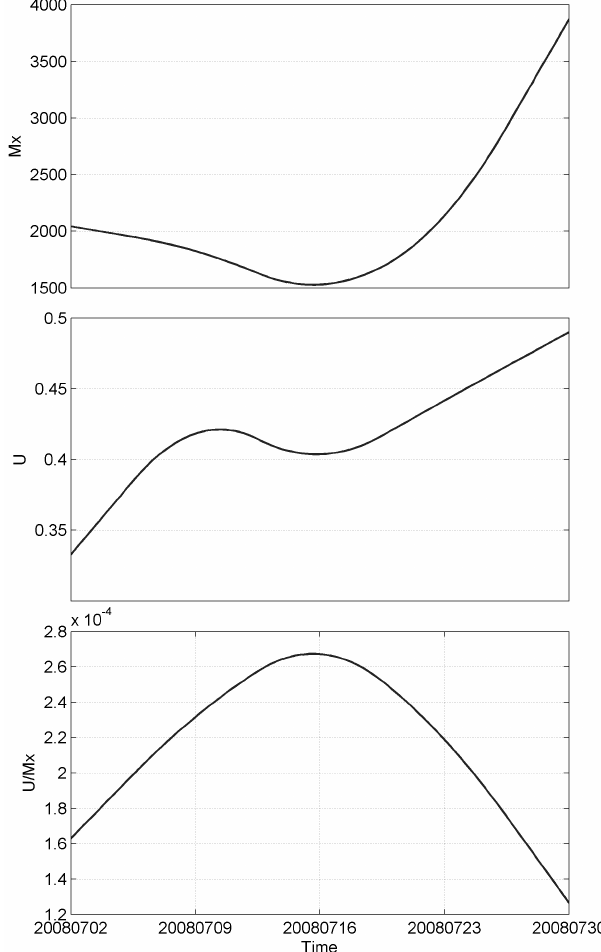
Figure 5. The offshore transport ( Mx , kgm − 1 s − 1 ), rotation speed of the mesoscale anticyclonic eddy ( U , cms − 1 ) and the normalized rotation speed to Mx ( U / Mx ), indicating the relative importance of the mesoscale anticyclonic eddy and offshore Ekman transport in the form of small-scale